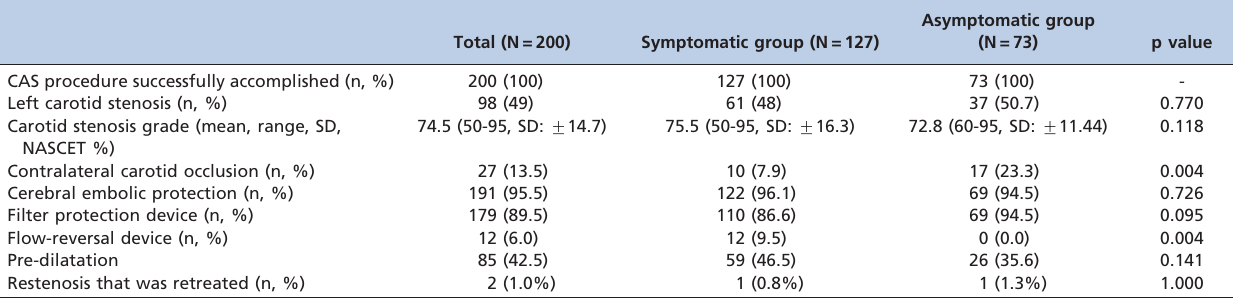
Table 3 - Patients’ baseline radiologic and procedural data in each group.